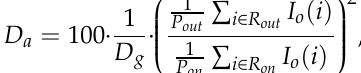
Figure 3. Filters for detecting edges. We use a bank of 2D Morlet wavelet kernels distributed in 36 orientations at 10 ◦